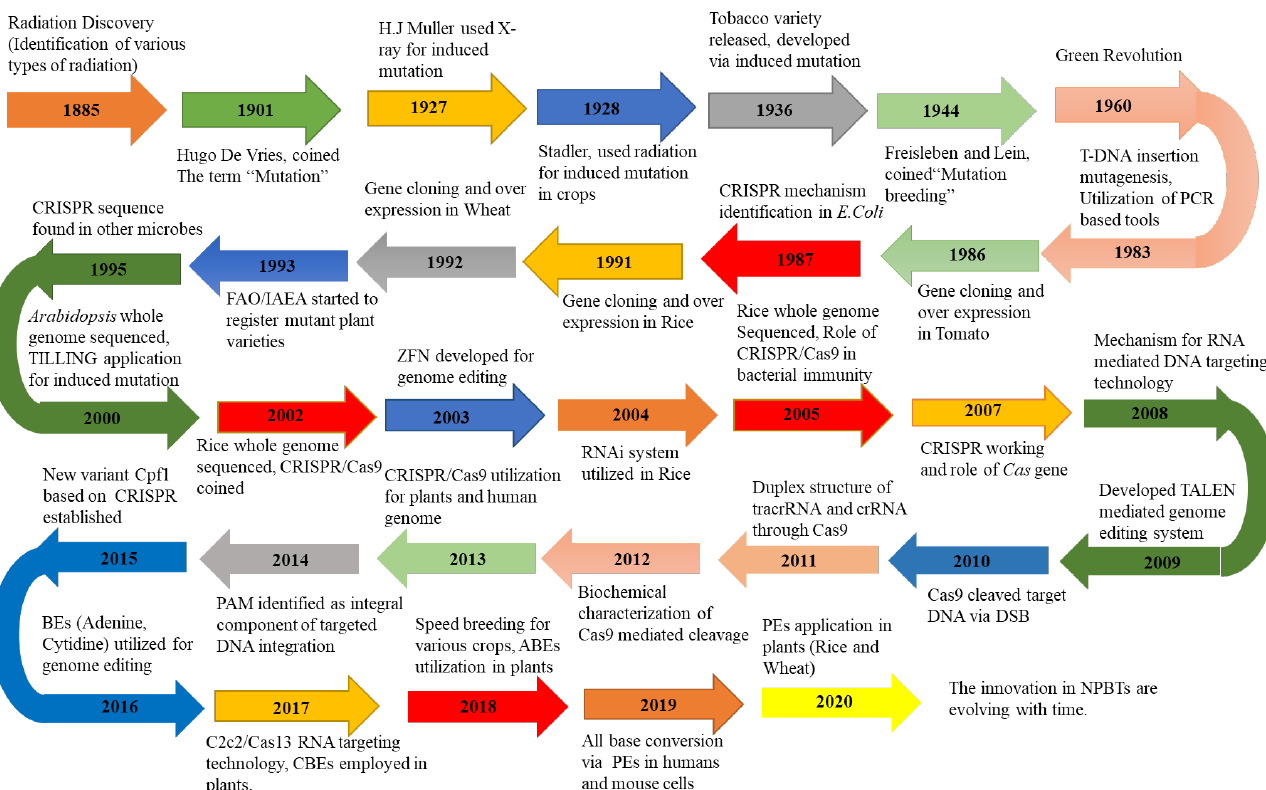
Figure 1. A brief history of different versions of GETs, showing historical events. CRISPR = clustered regularly interspaced short palindromic repeats; Cas9 = CRISPR-associated protein system 9; Cpf1 = CRISPR system from Prevotella and Francisella 1; BEs = base editors; PEs = prime editors; T-DNA = transgenic deoxyribonucleic acid; PCR = polymerase chain reaction; FAO = food and agriculture organization; IAEA = international atomic energy agency; DSB = double-stranded breaks; RNAi = RNA interference; tracrRNA = trans-activating CRISPR RNA; PAM = protospacer adjacent motif; NPBTs = novel plant breeding techniques.